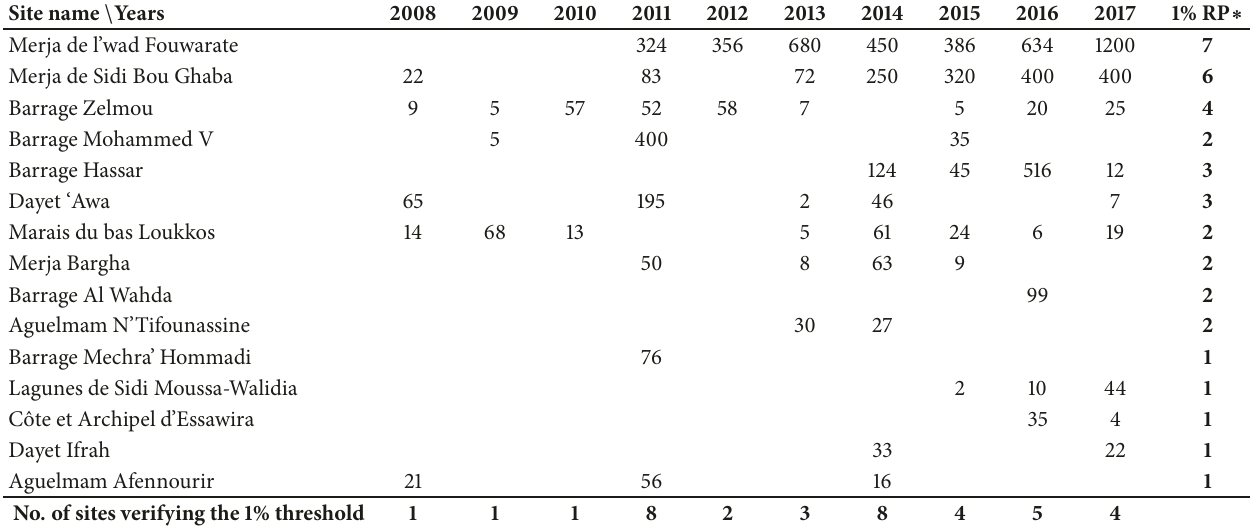
Table 2: Wetlands hosting, at least once, more than 1% of the Ferruginous duck’s regional